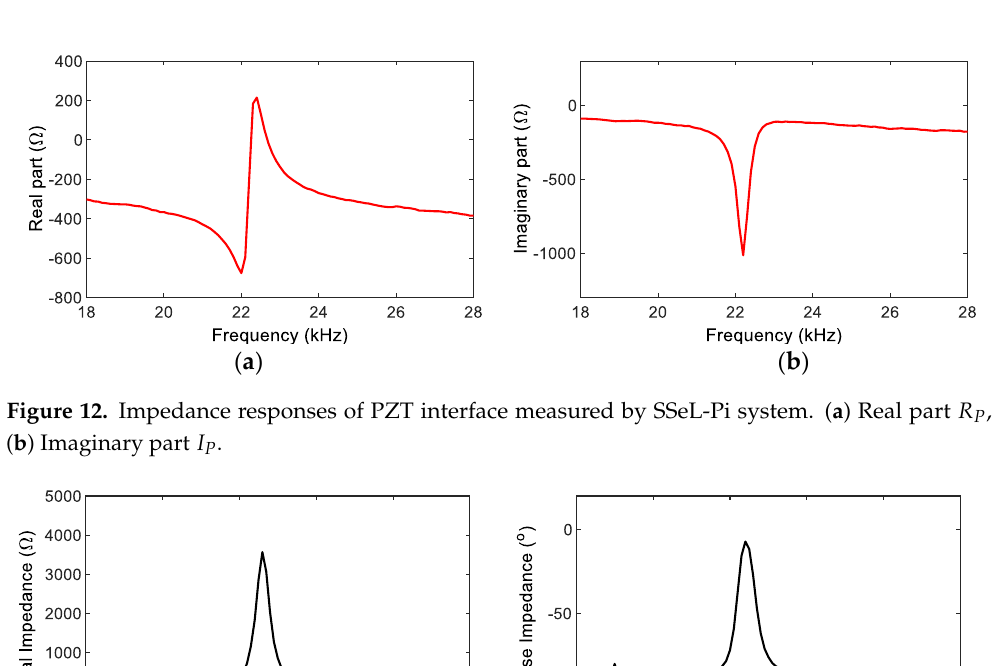
Figure 13. Impedance responses of PZT interface measured by HIOKI-3532. ( a ) Real impedance R H , ( b ) Phase impedance ϕ H .